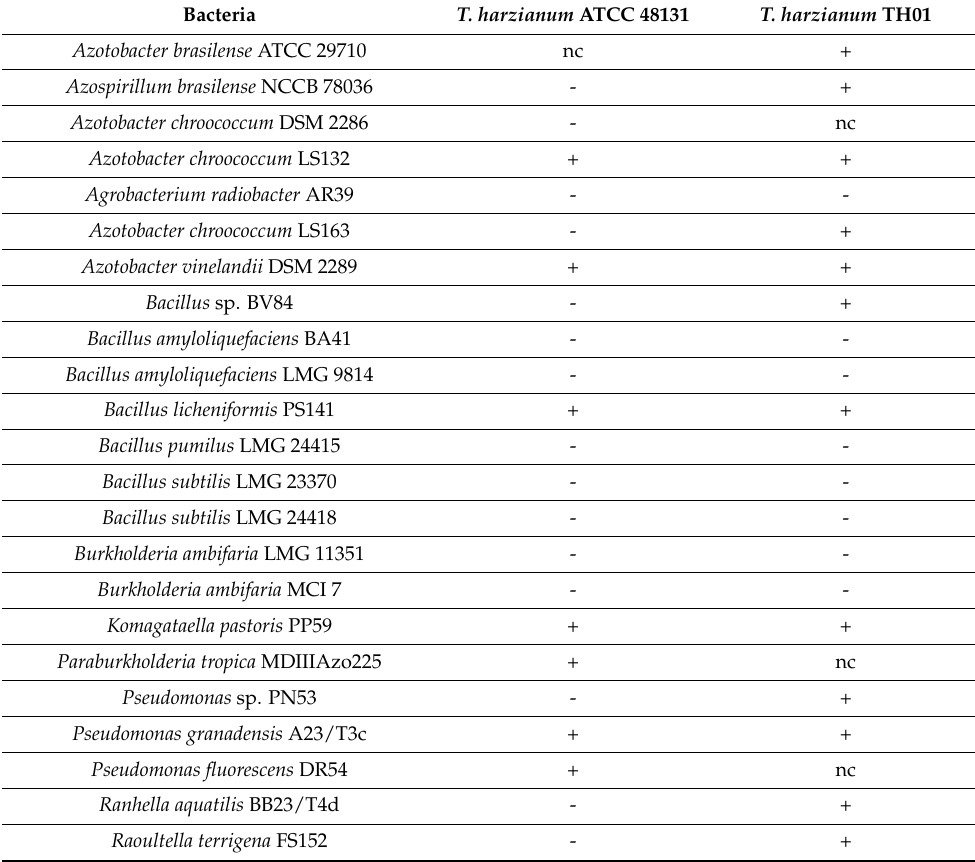
Table 4. Dual Compatibility Test among Bacteria and Fungi in Potato Dextrose Agar (PDA) Plates.